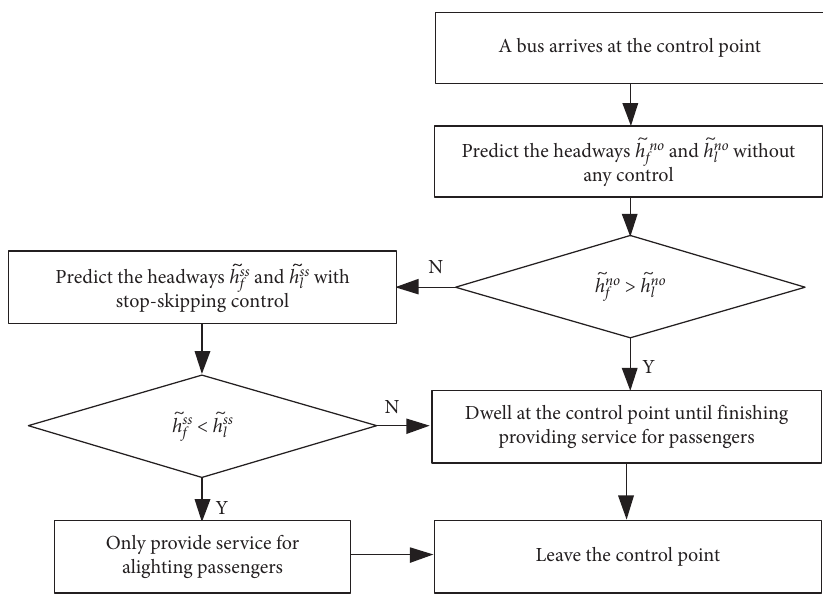
Figure 3: Principal control strategy procedure for buses at